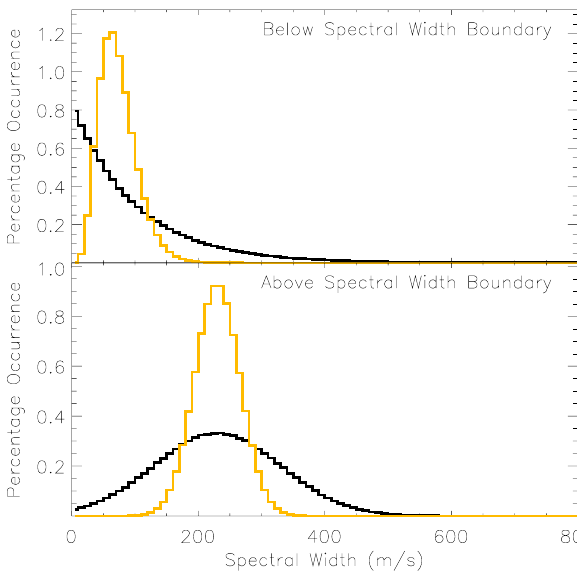
Fig. 6. The distribution of spectral width values below and above the spectral width boundary as determined by applying algorithm 2 to the simulated data set. The four different lines represent the re- sults from using four different spectral width threshold values (150, 200, 250, and 300 m/s) to identify the boundary.